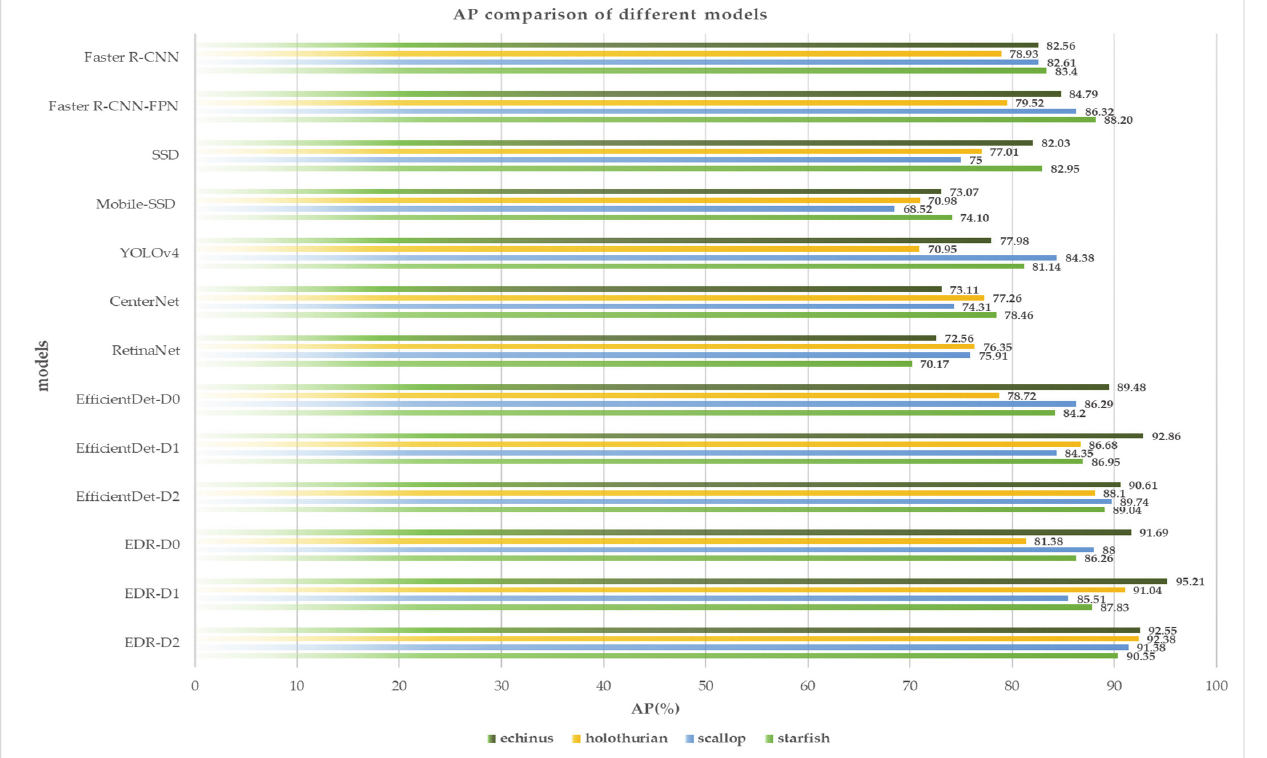
Table 4. The results of different categories between different models on homemade dataset. Category